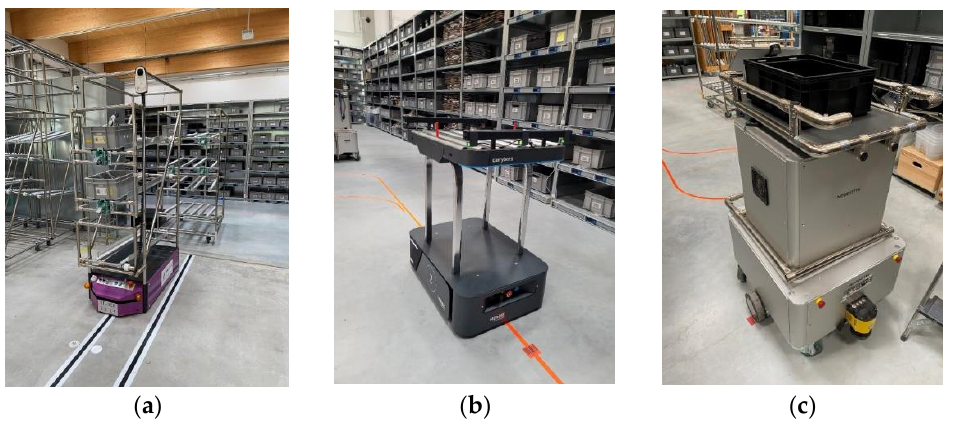
Figure 7. AGVs in “ Werk 150 ” : ( a ) AGV from the company Beewatec that navigates on a designed